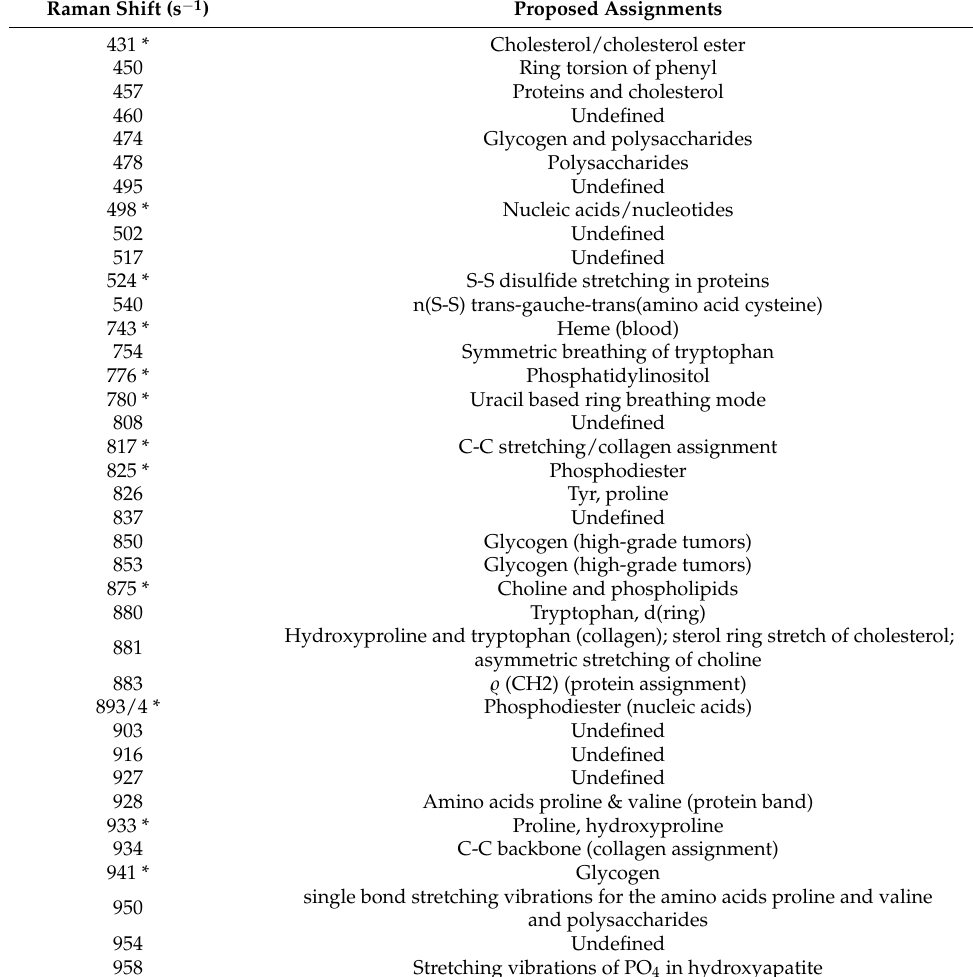
Table 2. Tentative assignment of the main Raman shifts according to previous studies